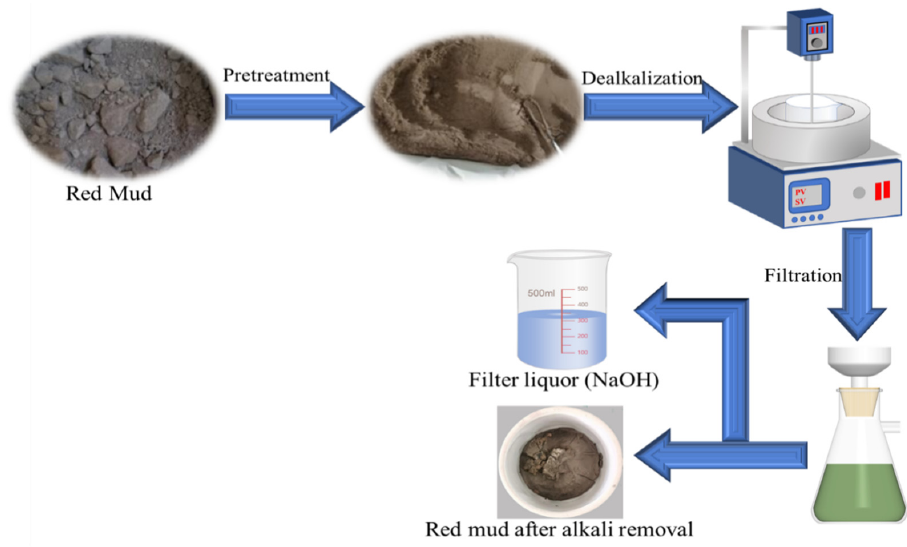
Figure 3. Experimental procedure.